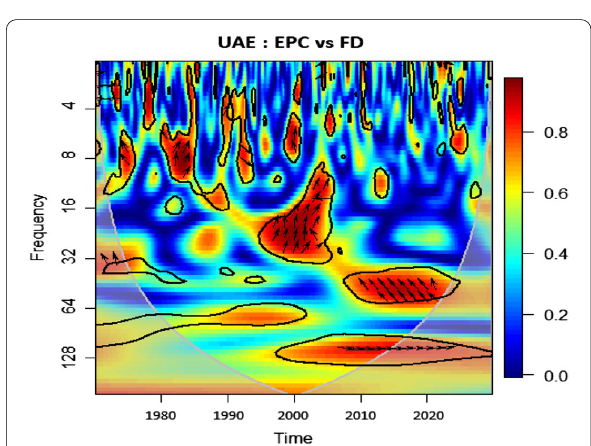
Fig. 3 Comovement between the electrical power consumption and financial development in UAE